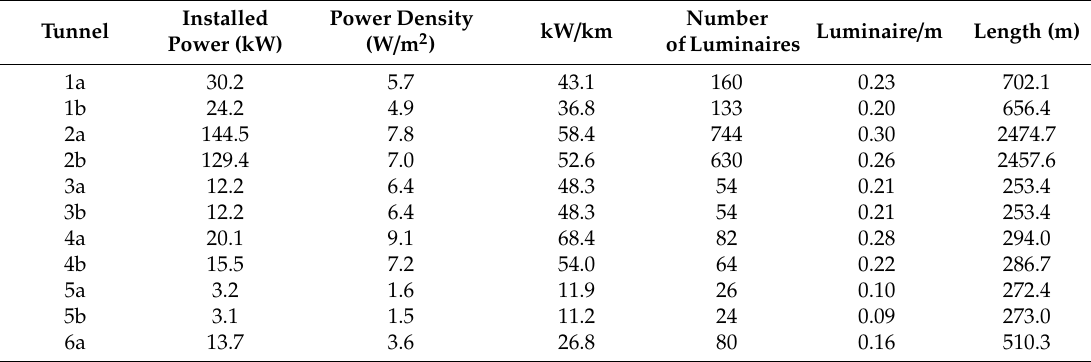
Table 3. Installed power and the corresponding energy indicators for the interior zone and nighttime stage of the examined tunnels (the luminaires of the interior zone were installed along the full length of the